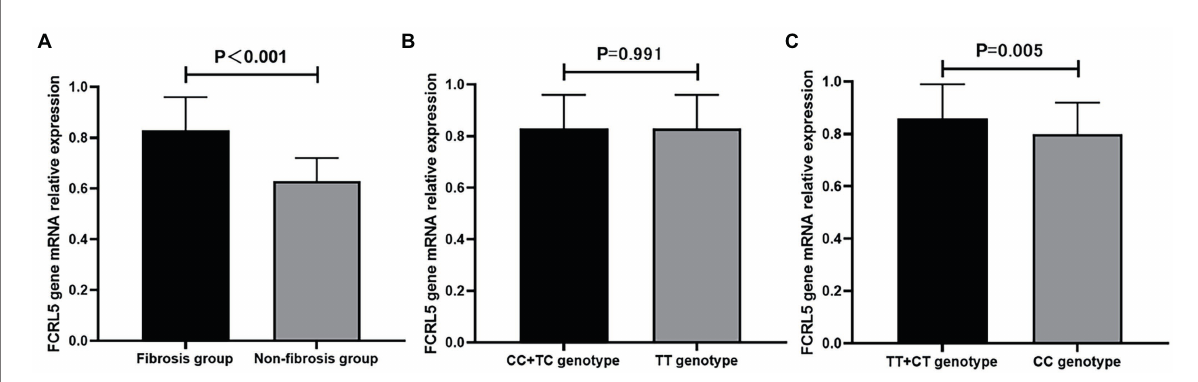
FIGURE 1 Comparison of FCRL5 mRNA expression levels. (A) Comparison between fibrosis and non-fibrosis group. (B) Comparison between different rs6427384 genotypes. (C) Comparison between different rs6692977 genotypes. FCRL5, Fc receptor-like